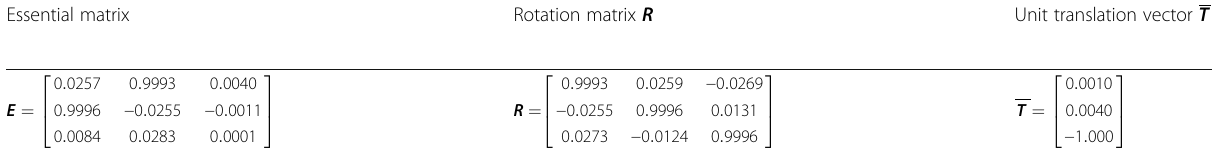
Table 3 Rotation matrix and unit translation vector results of the improved method Essential matrix Rotation matrix R